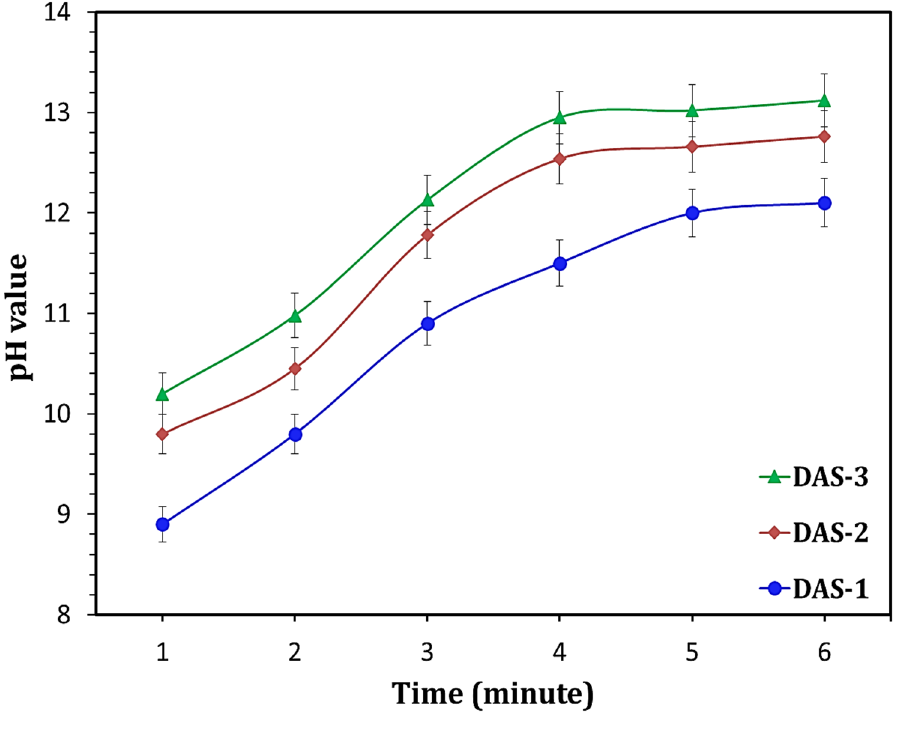
Figure 2. pH values of leachates of dry activator powders.